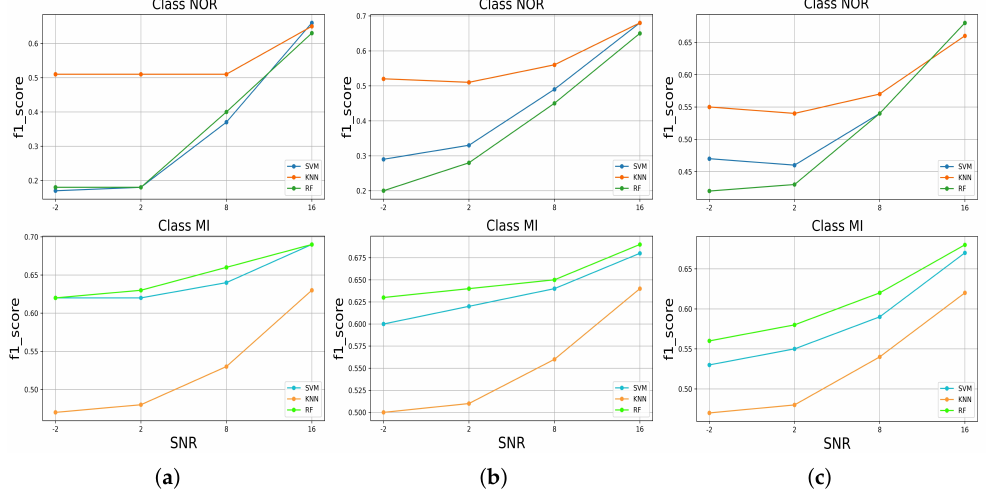
Figure 11. The F1-score performance of predicting the classes of the signals with added noises by the trained models, ( a ) for added muscle artifact noise, ( b ) for added electrode motion noise, ( c ) for added baseline wander noise.